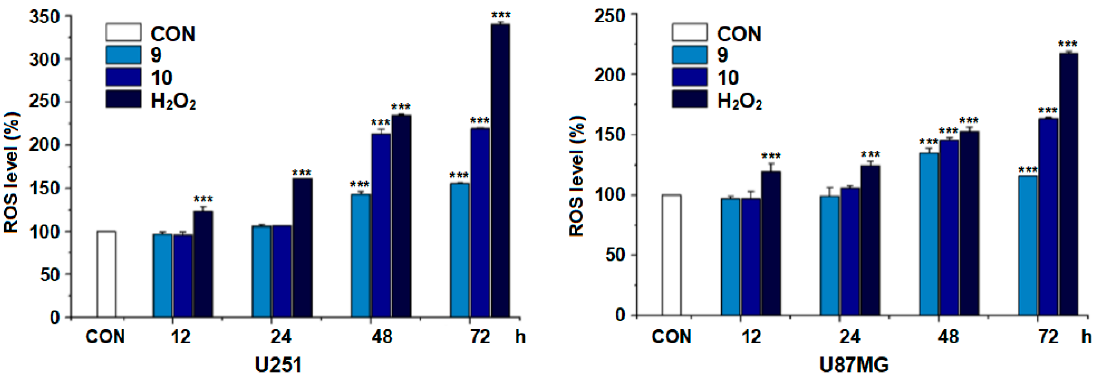
Figure 7. Effect of questiomycin A ( 9 ) and xanthocillin X ( 10 ) on the ROS production in glioma U251 and U87MG cells. Glioma U251 and U87MG cells were treated with 9 (20 µM), 10 (20 µM), and H 2 O 2 (6 µM) at different time points. Data are presented as the mean ± SD, n = 4; *** p < 0.001 (vs. CON).